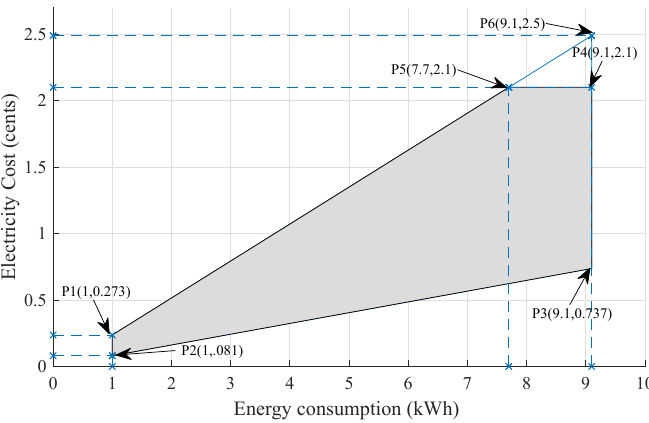
Figure 12. Feasible region of electricity cost and energy